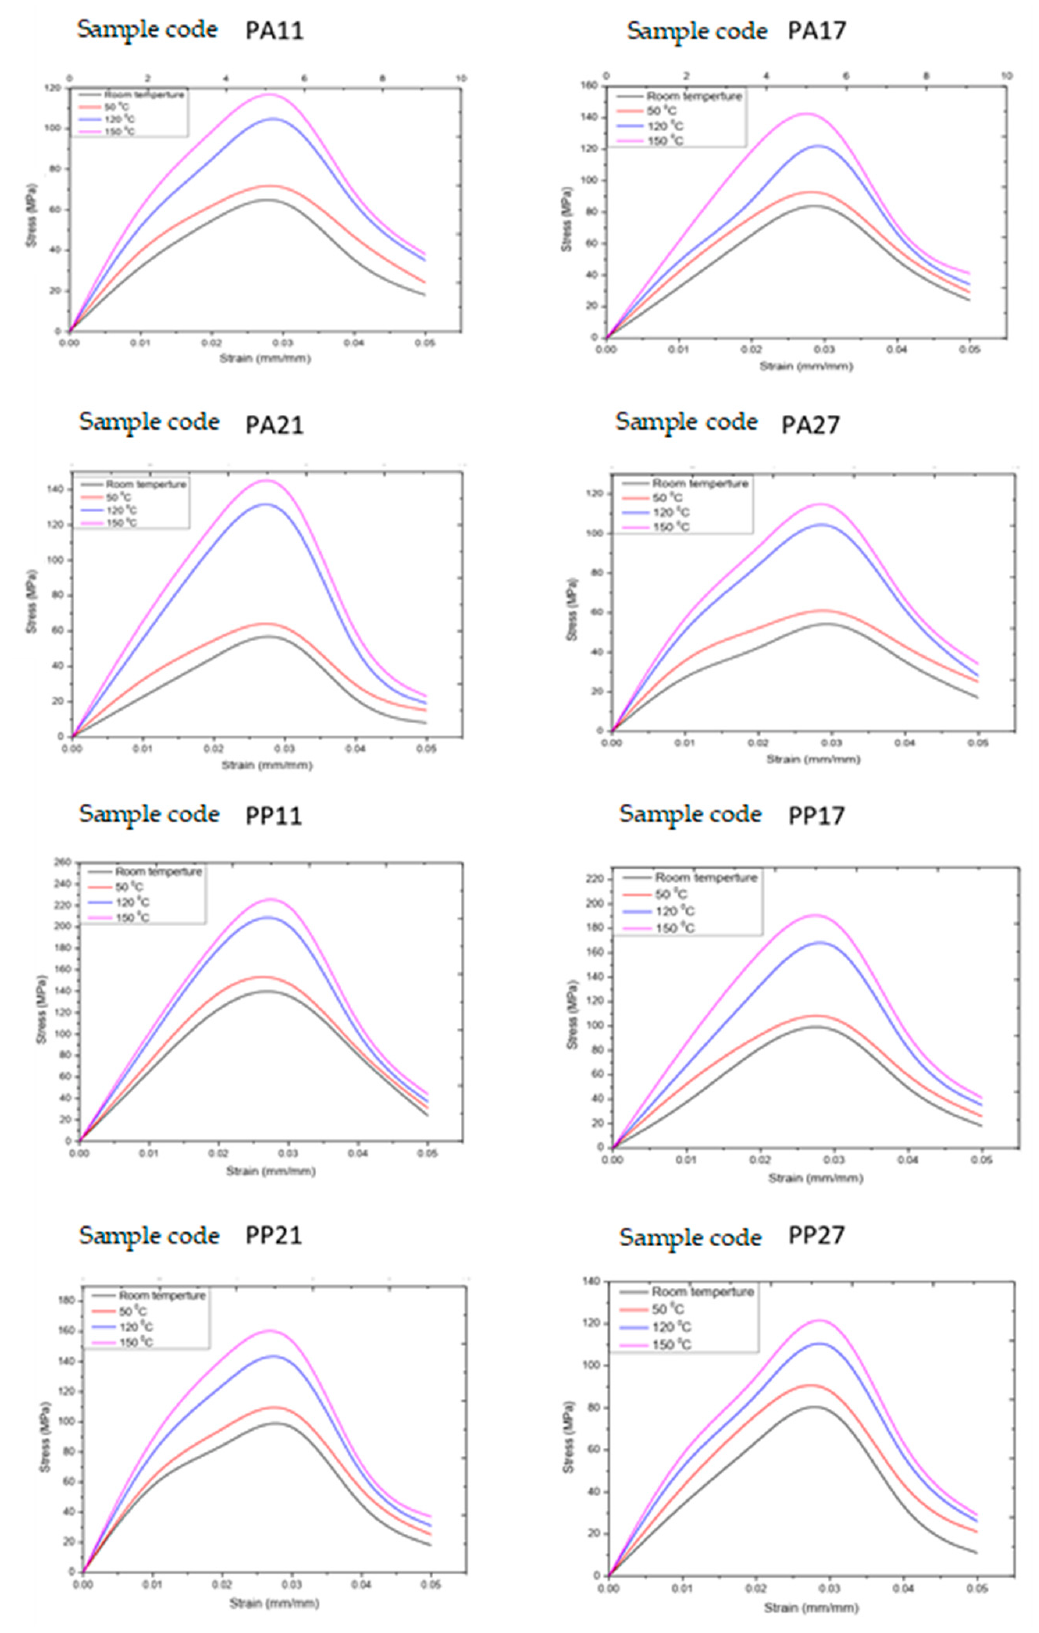
Figure A5. Tensile strength testing results of type B